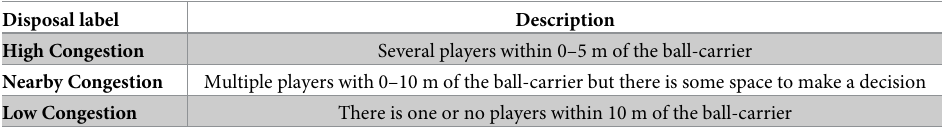
Table 1. Definition of the level of congestion when disposing of the